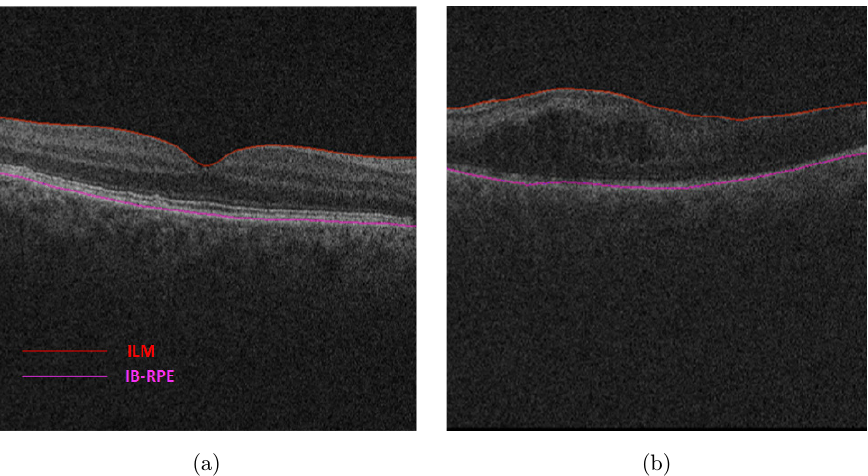
Fig. 2. (a) An example of B-scan layer segmentation of normal eye showing ILM and inner boundaries of RPE (IB-RPE) and (b) An example of abnormal eye with pathologic